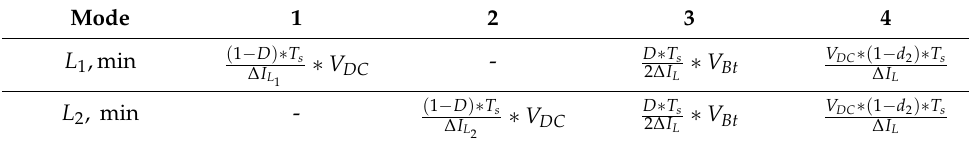
Figure 9. The configuration of the multi-input converter with MEG DC sources. Table 2. Inductance equations for different operation modes.